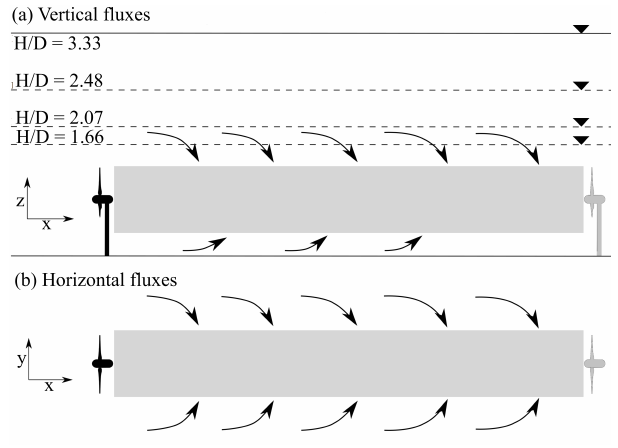
Fig. 1. Turbine wake region (shadowed in grey) used to integrate the mean kinetic energy equation terms. Representation of the fluxes in the (a) vertical and (b) lateral directions. Flow is from left to